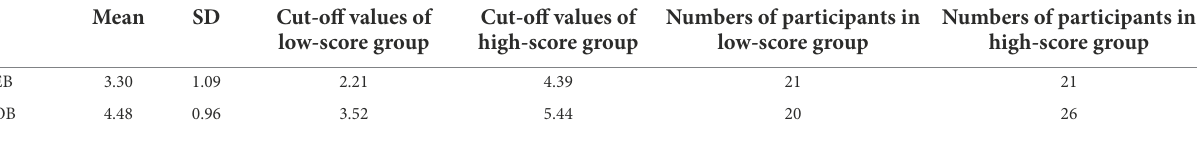
TABLE 1 Means, SD, cut-off values, and numbers of low-and high-score groups of EB and OB. Mean SD Cut-off values of Cut-off values of low-score group high-score